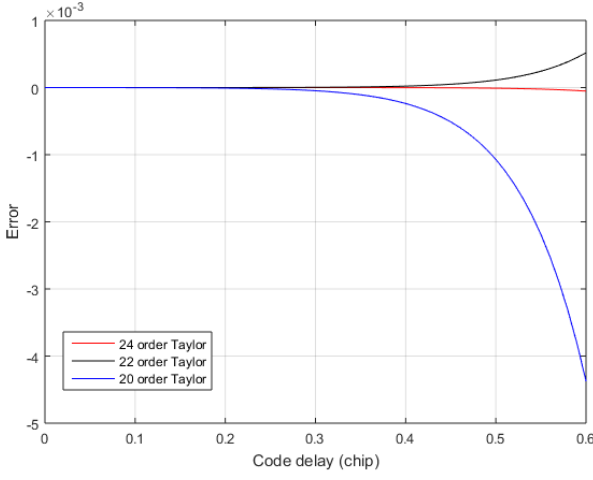
Figure 9. The Taylor approximation error when β = 1.6.